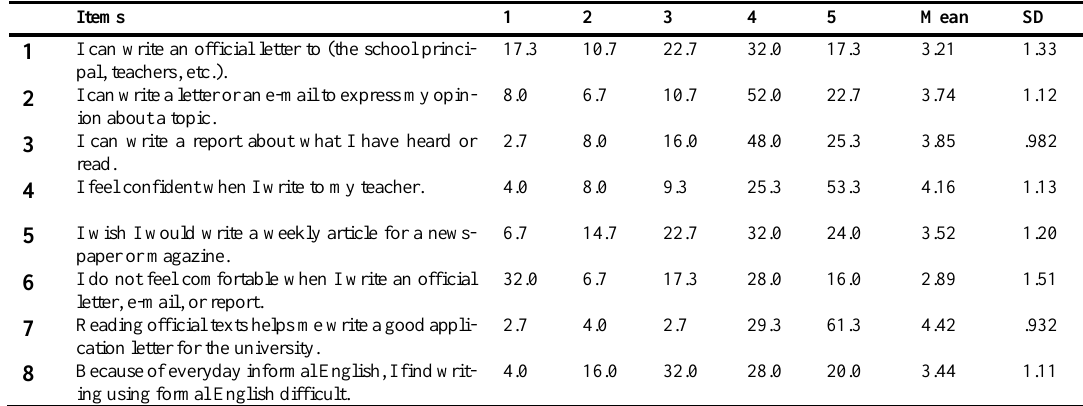
Table 4. Attitudes official purposes of writing in